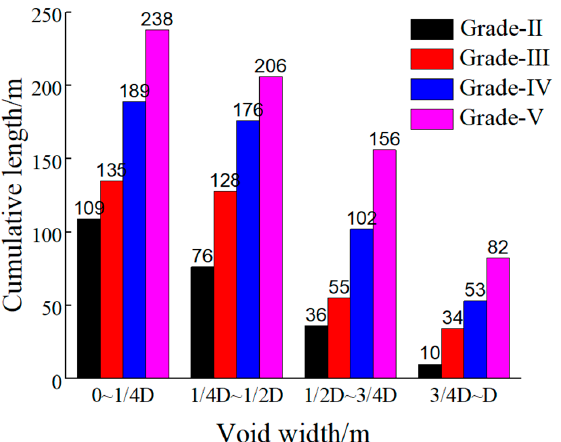
Figure 2. Cumulative length of tunnel with different base void lengths. Figure 3. Cumulative length of tunnel with different base void widths. Figure 3. Cumulative length of tunnel with different base void